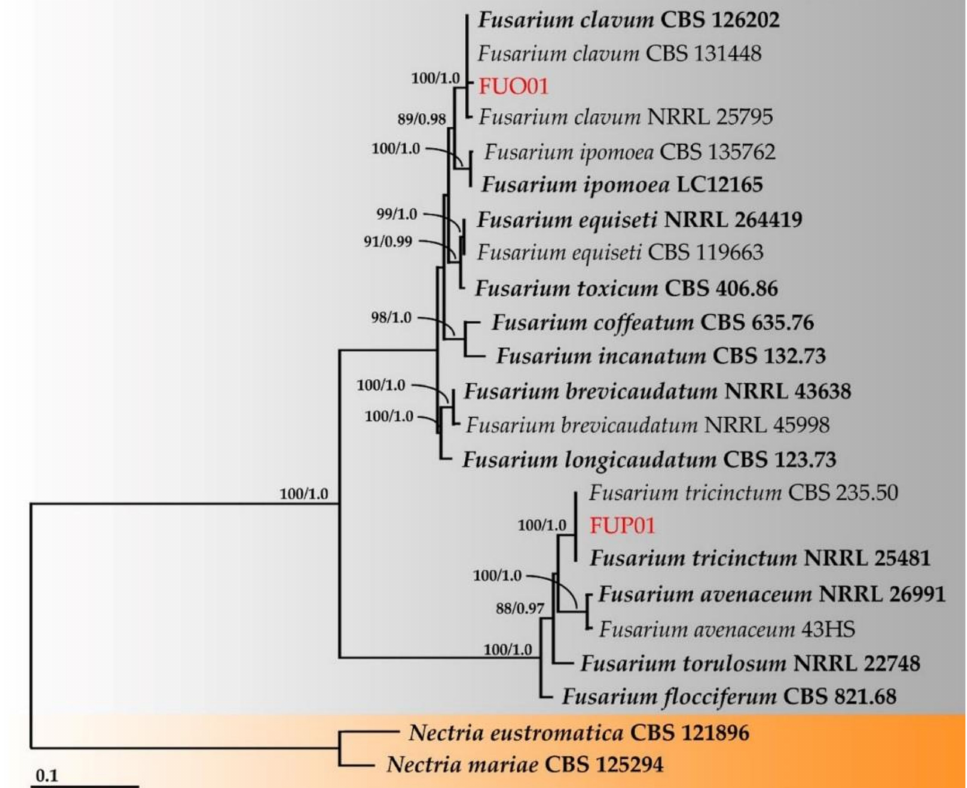
Figure 6. Phylogram derived from the maximum likelihood analysis of 23 taxa of the combined ITS, rpb2 , and tef1 sequences. Nectria eustromatica CBS 121896 and N. mariae CBS 125294 were used as the outgroups. The numbers above the branches represent bootstrap percentages ( left ) and Bayesian posterior probabilities ( right ). Bootstrap values ≥ 75% and Bayesian posterior probabilities ≥ 0.90 are shown. The scale bar represents the expected number of nucleotide substitutions per site. The sequences of the fungal species obtained in this study are in red. The type species are in